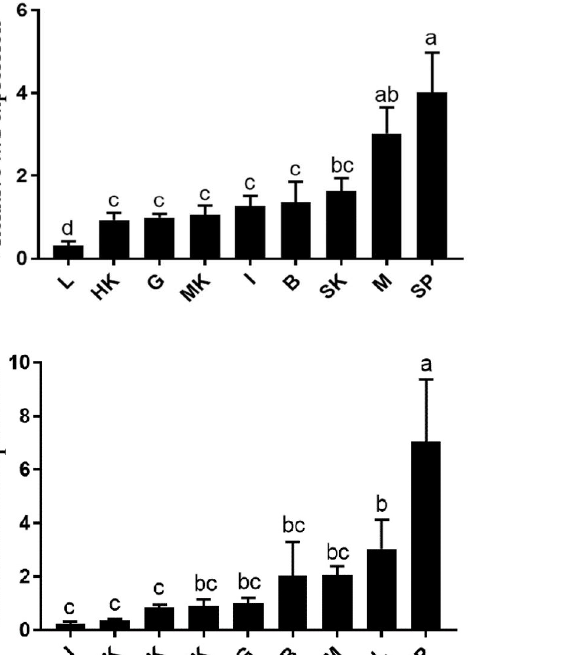
M: muscle; SK: skin; L: liver; I: intestine; SP: spleen; G: gonads; HK: head kidney; MK: middle kidney;